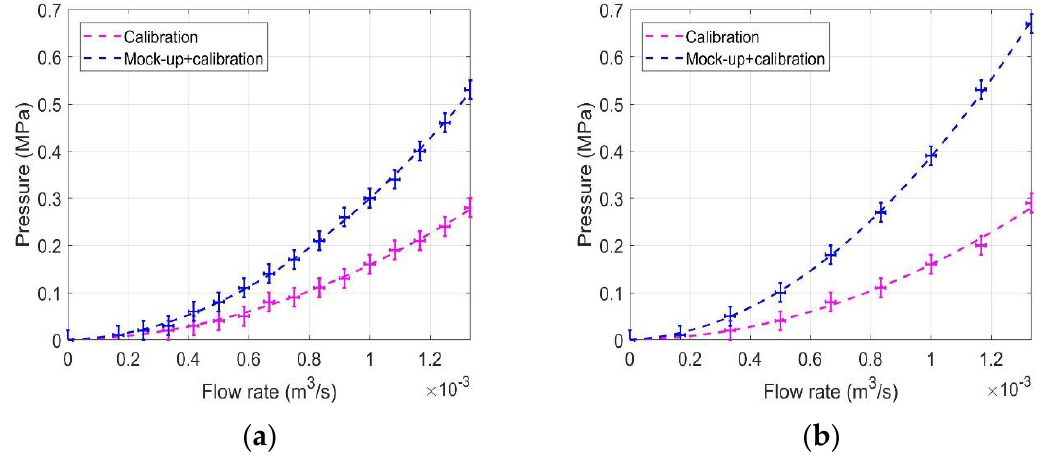
Figure 9. Pressure drop with respect to flow rate evaluated during the calibration tests and the tests with the mock-ups of the cavities equipped with ( a ) MCs and ( b ) RRs. The error bars derived from the measured data are reported, together with the corresponding fits of the two datasets.